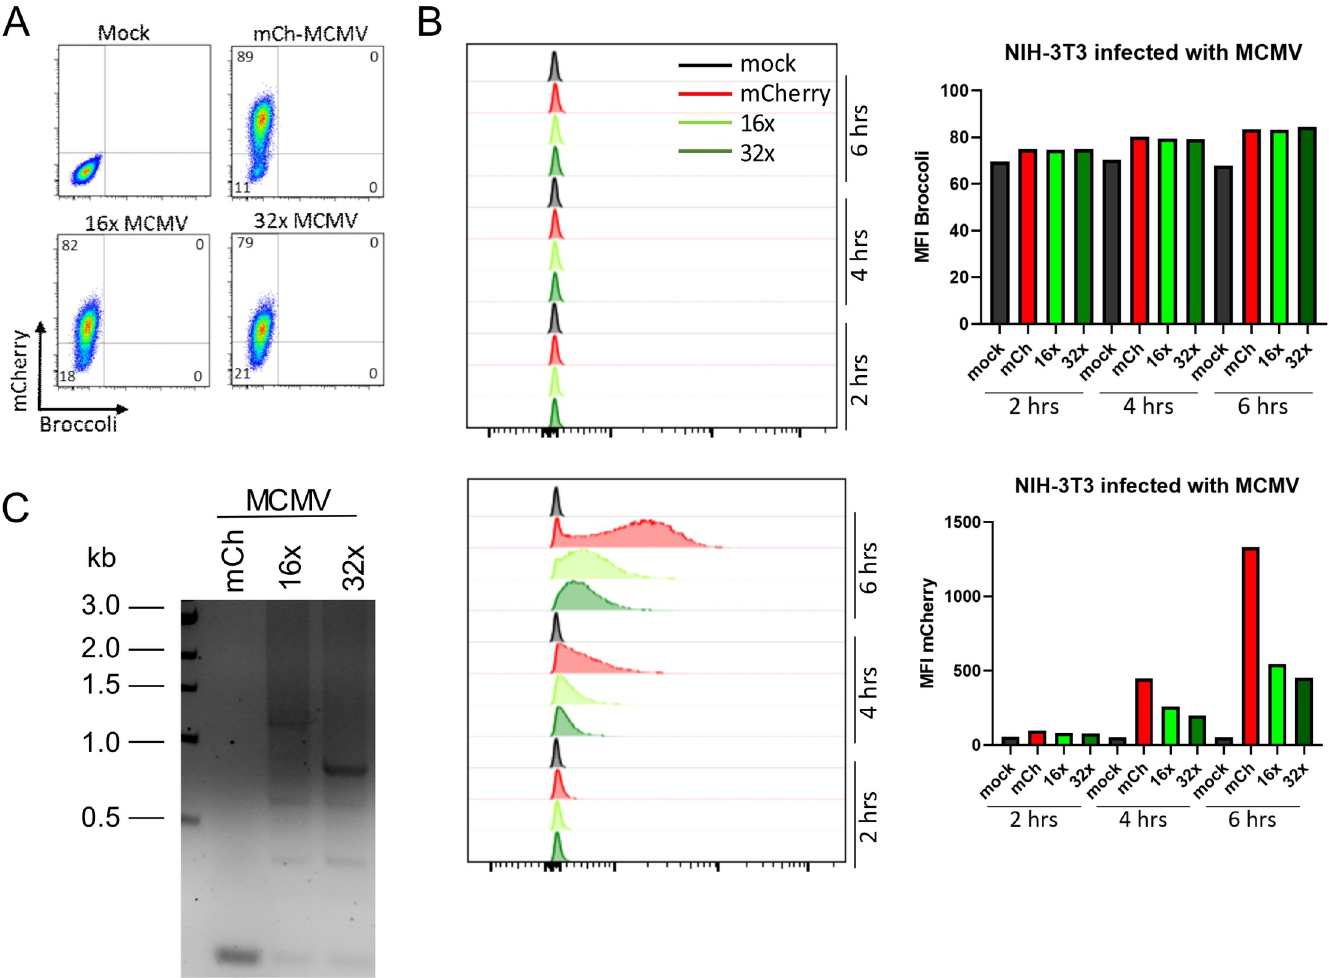
Fig 6. NIH-3T3 cells infected with Broccoli-MCMV viruses show reduced mCherry expression but no detectable Broccoli fluorescence. (A, B) NIH-3T3 cells were infected with undetermined MOI of mCherry-MCMV, 16x-MCMV or 32x-MCMV and analyzed by flow cytometry at 2, 4 or 6 hours post-infection. (A) Dot plots show cells at 6 hours post-infection. (B) Histograms and graph show progression of the viral infection/replication as shown by the mean fluorescence intensity of mCherry. (C) Standard PCR for Broccoli from DNA isolated from NIH-3T3 cells infected with mCh-MCMV, 16x-MCMV and 32x-MCMV, at 6 hours